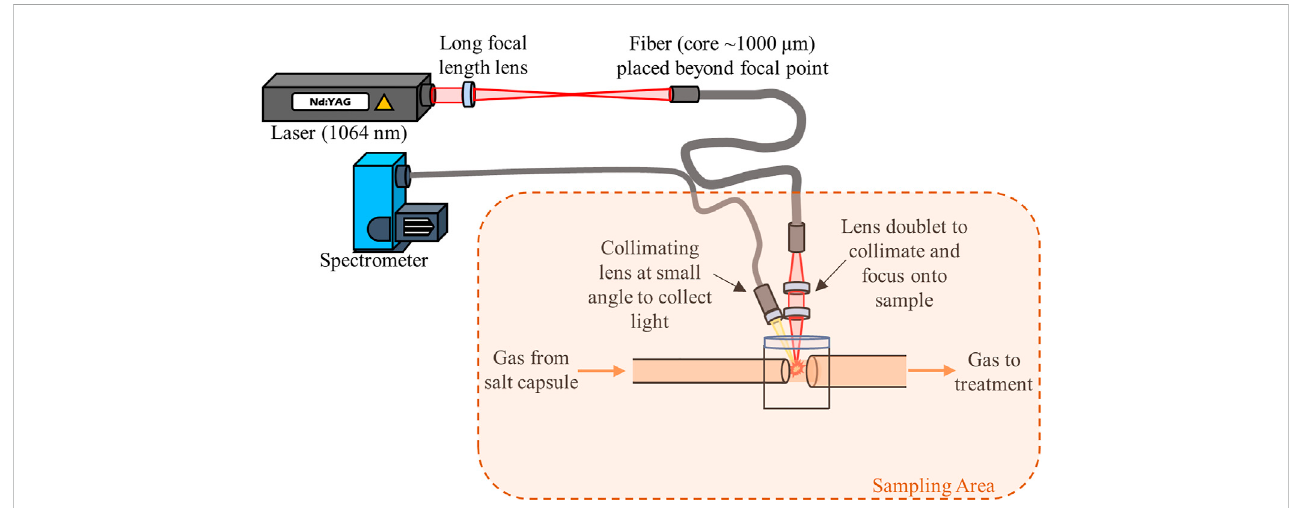
FIGURE 2 Example sensor test bed with a FO-LIBS setup being used to measure the fl ow across a sudden expansion. Fiber optics are used to prevent damage to sensitive equipment, such as the laser head and electronics.